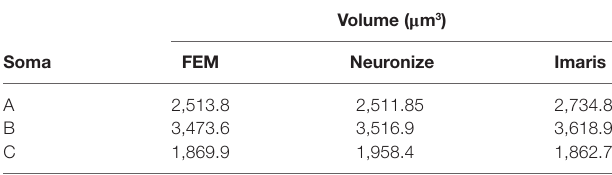
tABLe 1 | Estimated soma volumes using FEM, Neuronize, and Imaris.